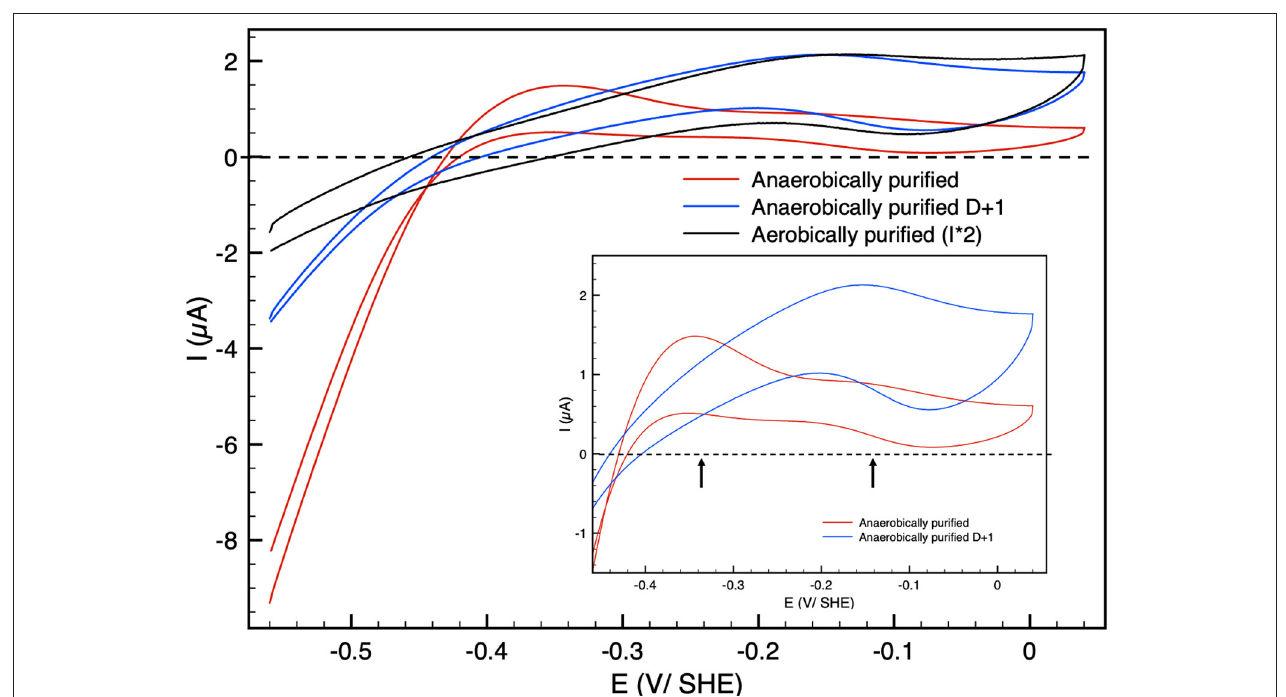
FIGURE 1 | Cyclic voltammograms of Hnd hydrogenase adsorbed on a PGE electrode; black: aerobically-purified enzyme, red: anaerobically-purified enzyme, blue: anaerobically-purified enzyme, stored 1 day (D + 1) anaerobically at 4 ◦ C. The current for the aerobically-purified enzyme (black line) was multiplied by two for the sake of clarity. Insert: zoom in the high potential range. Scan rate: 20 mV/s, T = 30 ◦ C, 1 bar H 2 , phosphate buffer pH 7, ω = 3,000 rpm.